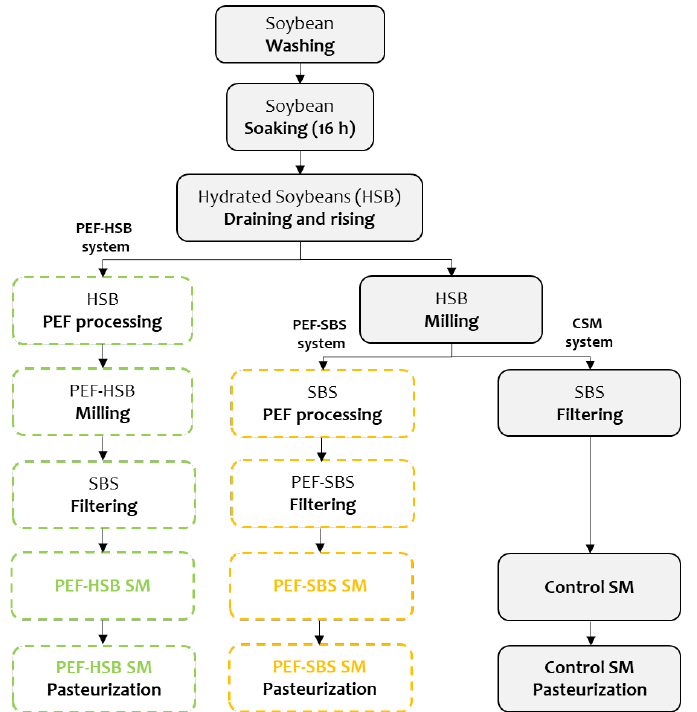
Figure 1. General soymilk (SM) preparation procedure with the application of low-intensity pulsed electric fields (PEFs) in hydrated soybeans (HSB) and soybean slurry (SBS). Low-intensity PEF processing was applied as follows: First, 100 g of HSB immersed in tap water (1:4, HSB: water) and 100 mL of SBS were placed in the PEF treatment chamber, applying 10, 55, and 100 monopolar exponential pulses ( n ) of 4 μs width at different electric field strength ( E ) of 2, 6, and 10 kVcm − 1 , according to the experimental design described below. Processing conditions were selected based on preliminary studies; data are not shown. Initial (15–18 ◦ C) and final (27–36 ◦ C) temperatures were monitored with a thermometer before and immediately after PEF processing, respectively. Immediately af-